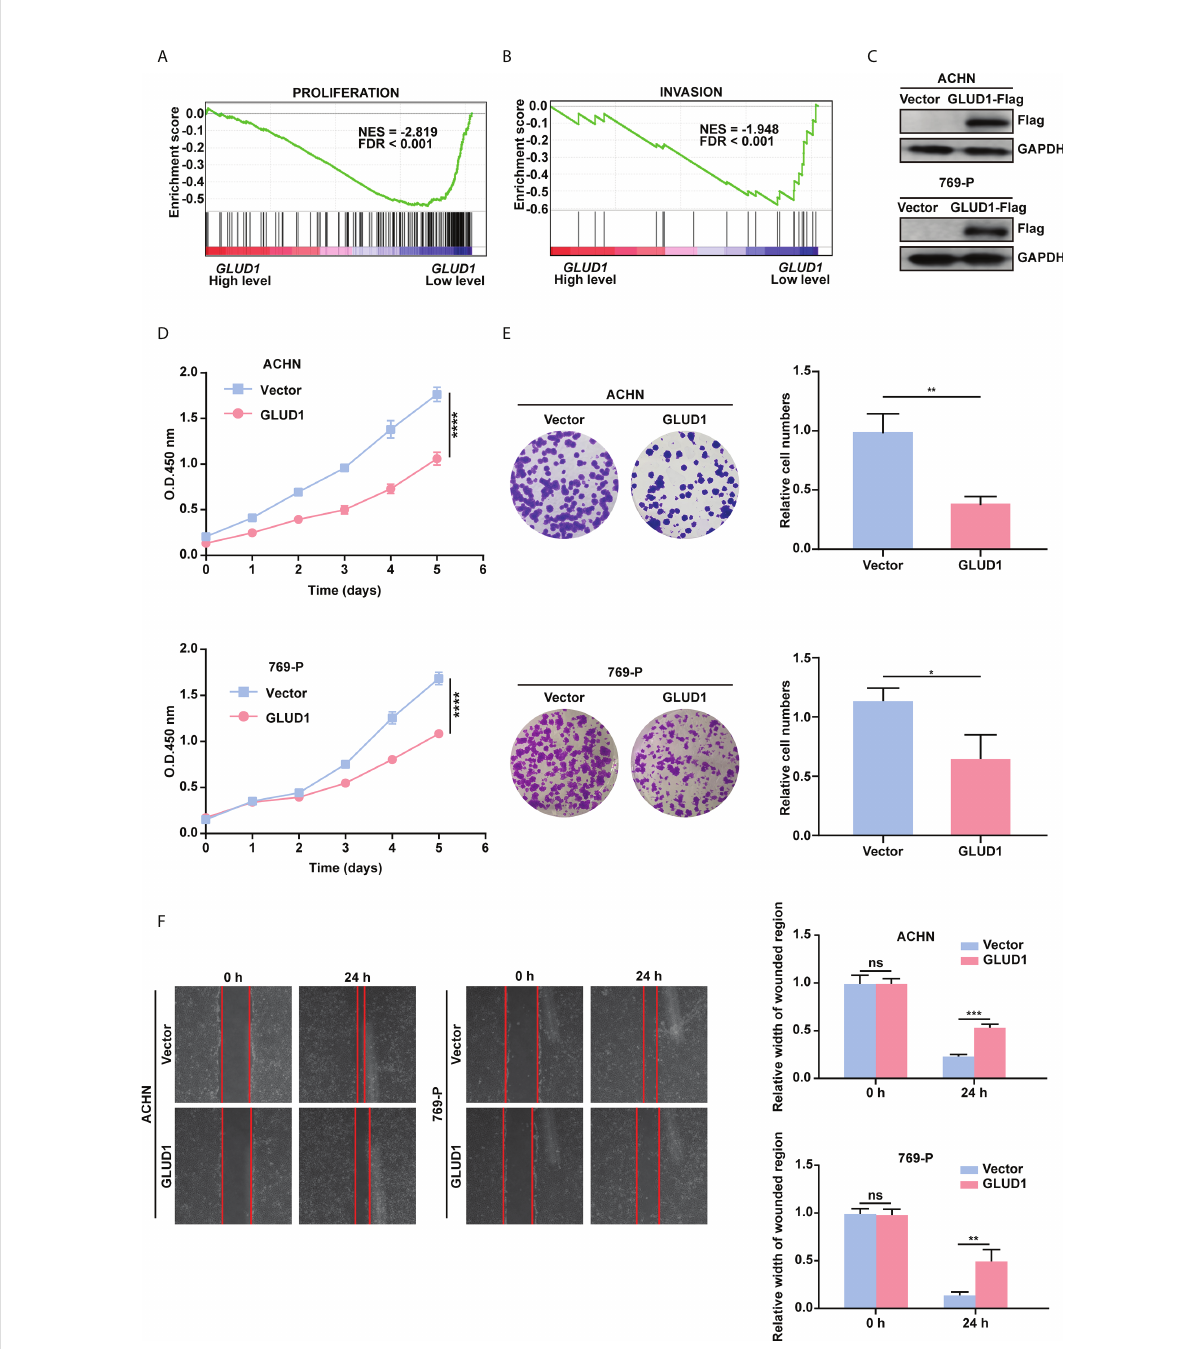
FIGURE 4 GLUD1 suppresses the proliferation and migration of RCC cells. (A, B) Enrichment plots of gene expression signature for proliferation (CHIANG_LIVER_CANCER_SUBCLASS_ PROLIFERATION_DN) and invasion (MINGUEZ_LIVER_CANCER_VASCULAR_INVASION_ DN) were obtained by GSEA according to GLUD1 mRNA levels. The ccRCC samples from TCGA_KIRC database were divided into high and low GLUD1 expression groups according to the median value of GLUD1 RNA-seq quanti fi cation results. (C) ACHN and 769-P cells were transfected with GLUD1-Flag expression plasmid, and protein levels were detected using western blot assay. b -actin was used as a loading control. (D – F) ACHN and 769-P cells were transfected with GLUD1-Flag. Vector-transfected ACHN and 769-P cells served as control. CCK8 viability assays were used to analyze cell viability (D) . Colony formation assays were performed to detect cell proliferation (E) . Wound healing assays were performed to detect cell migration (F) . The relative migration distance is quanti fi ed. ns, no signi fi cance; * P < 0.05; ** P < 0.01; *** P < 0.001; **** P <